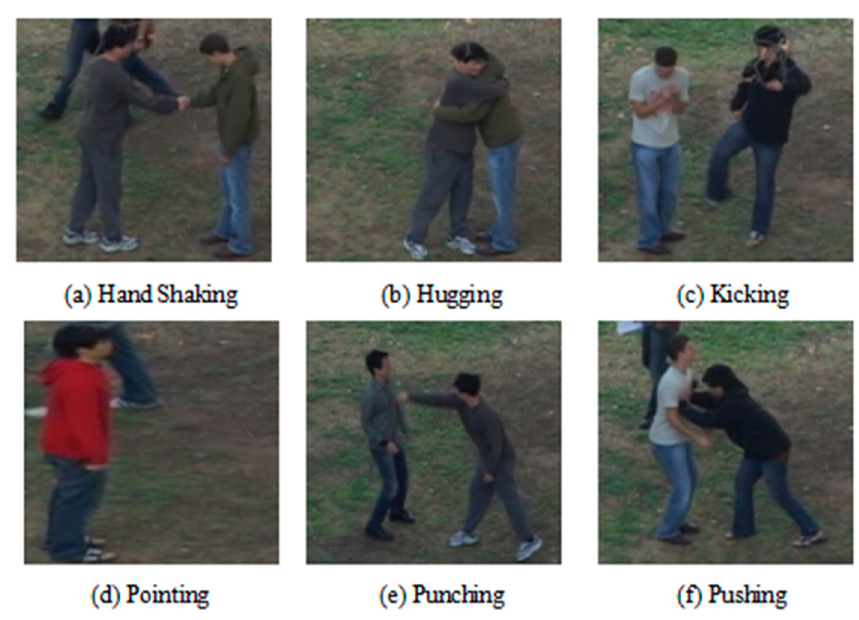
Figure 9. Example of the UT set 2 dataset.